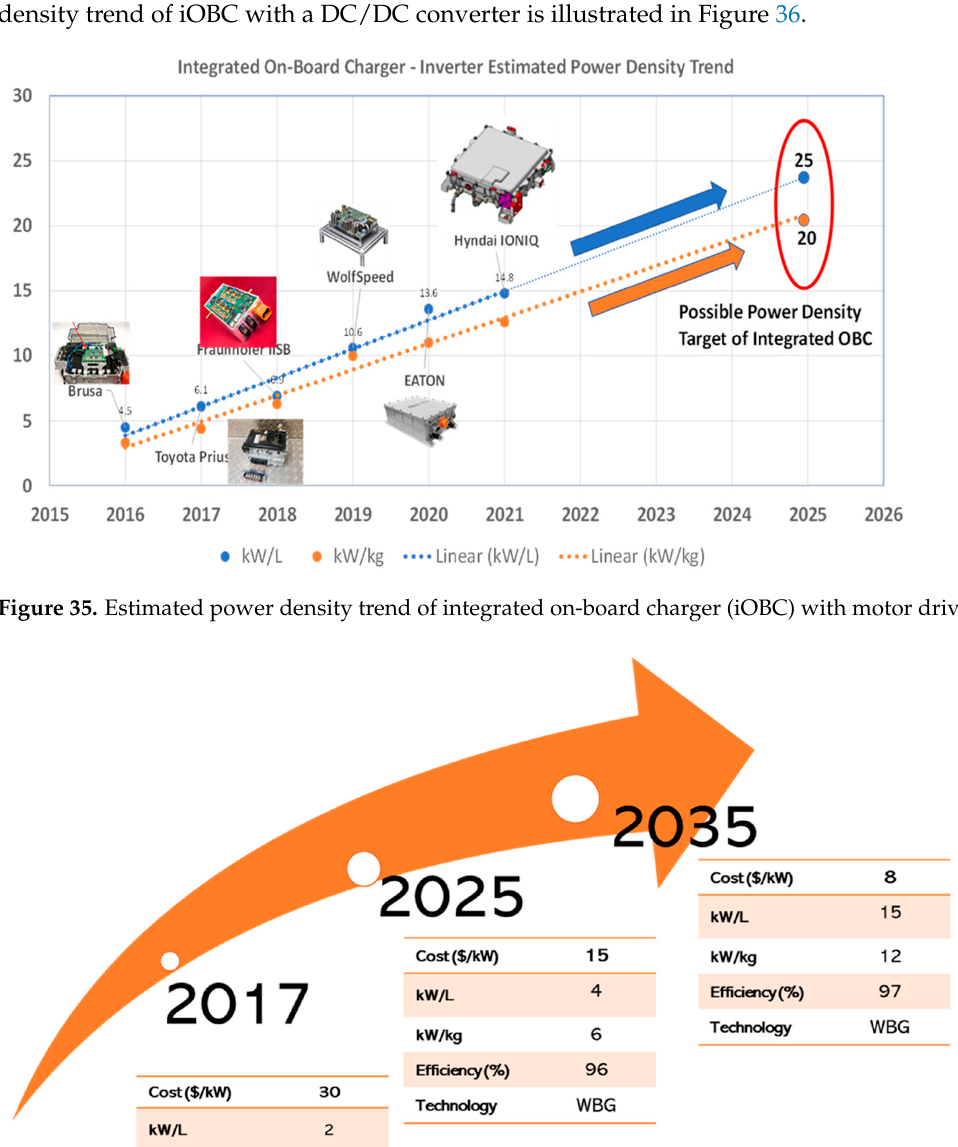
Figure 34. Estimated power density state of the art for commercially available integrated on-board chargers (iOBC).